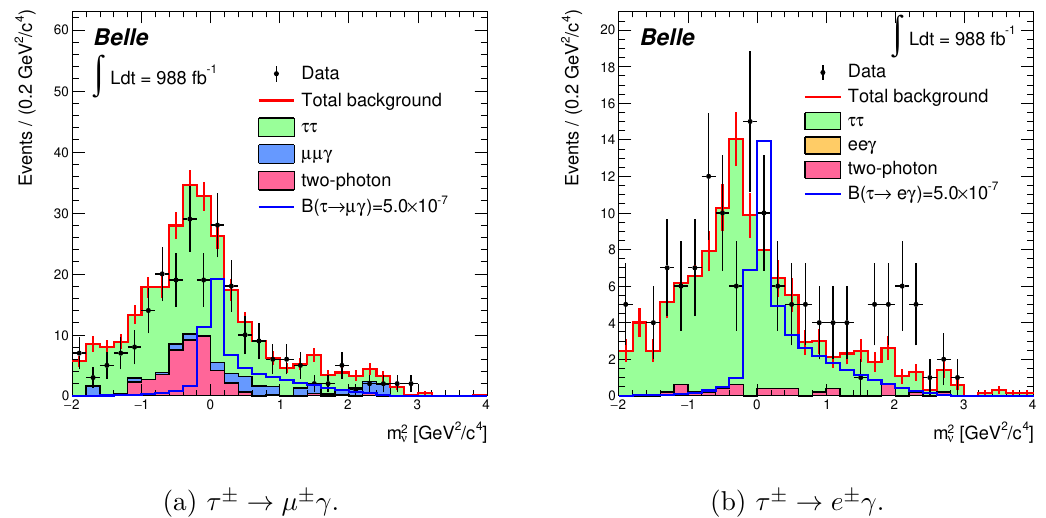
) for (a) τ ± → µ ± γ and ν requirement and ν